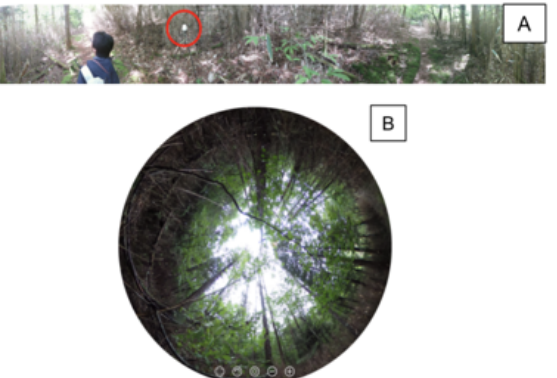
Figure 4. A panorama ( A ) and 360 degree ( B ) photos around the microphone array.